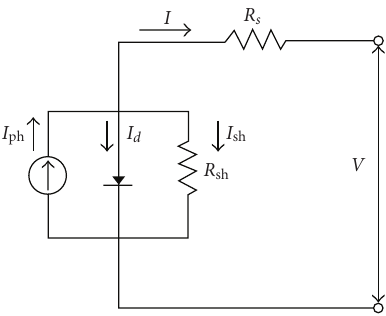
Figure 7: Equivalent circuit of the one-diode model.